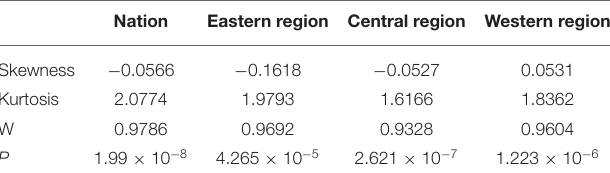
TABLE 2 | Normality test statistical results for the nation and the eastern, central, and western regions. Nation